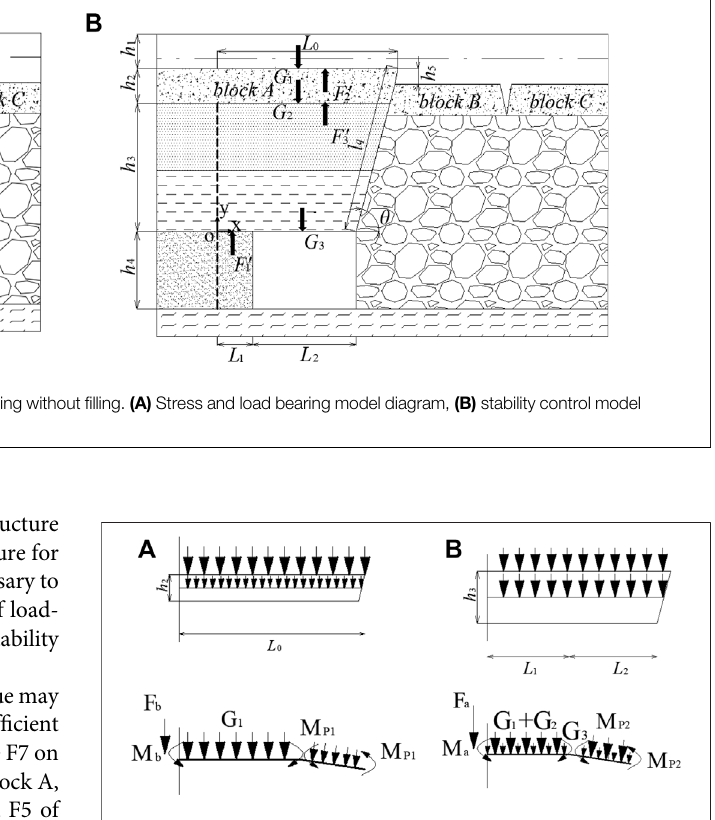
FIGURE 4 | Stress diagram of anchoring roof beam and block A. (A) Block A, (B) anchor roof